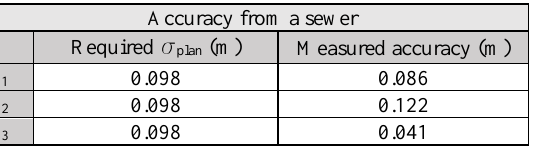
Table 3. the required accuracy in comparison with the measured accuracy for a sewer.